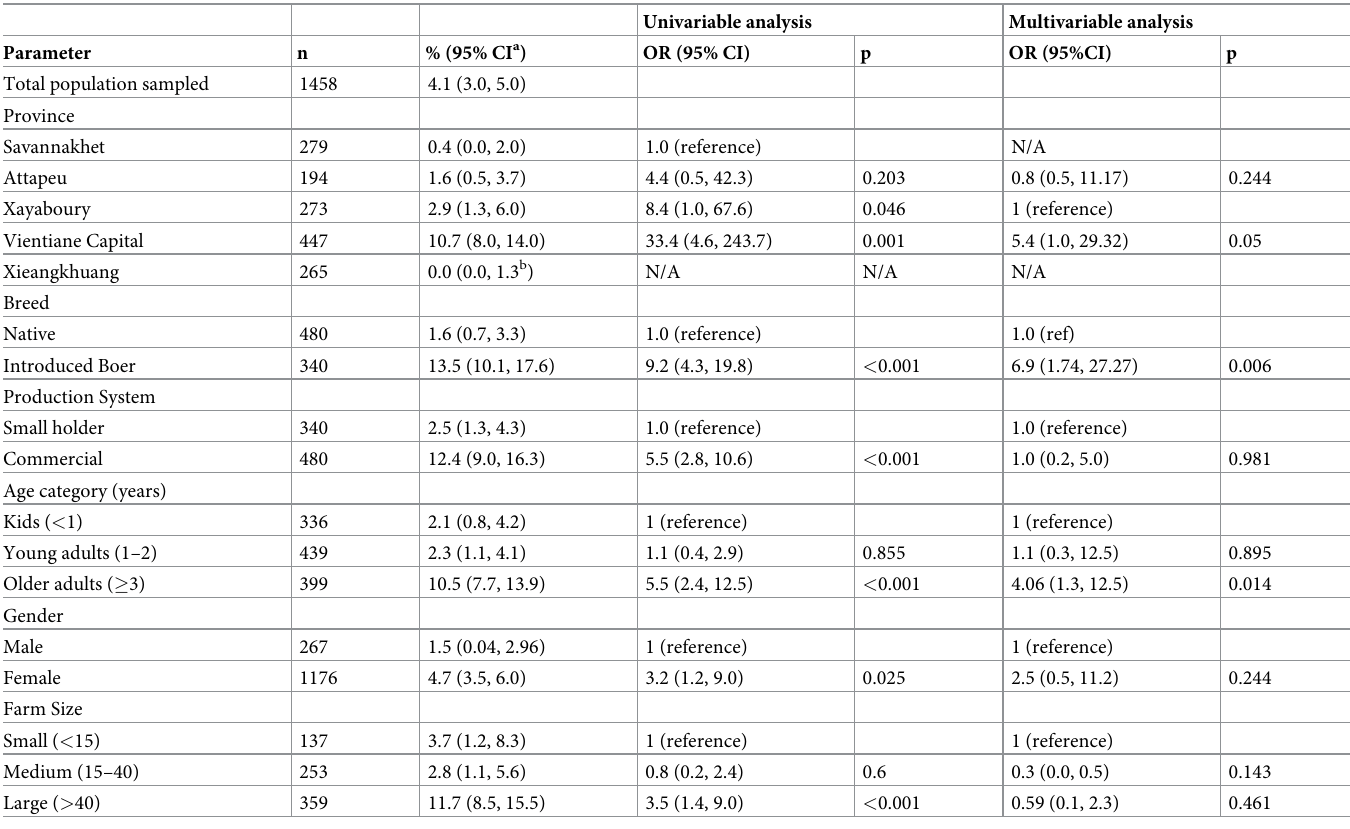
Table 2. Results of univariable and multivariable logistical regression on C . burnetii